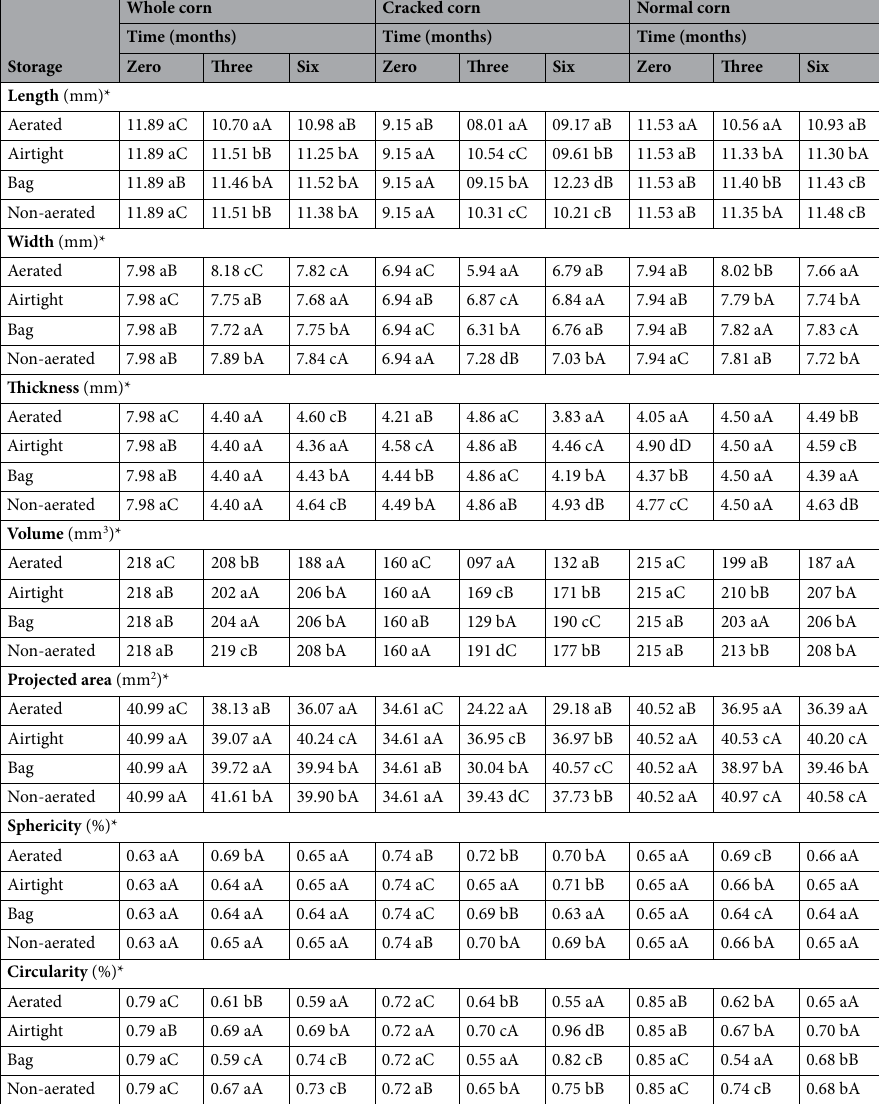
Table 1. Physical dimensions of the corn kernels stored under different systems and durations. *Means followed by the capital letter in the line for each storage time and lowercase in the column for each storage form, do not differ at 5%